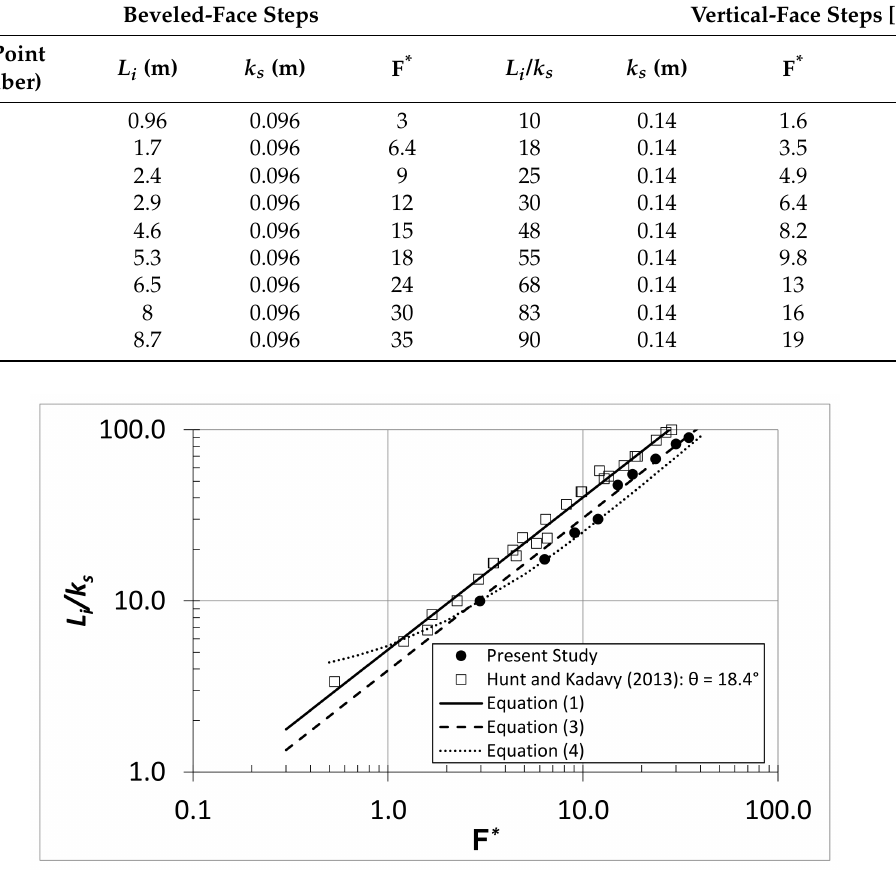
Figure 4. Visually observed free-surface inception point ( L i ) normalized by the step roughness ( k s ) for a vertical face step ( k s = h cos ( θ )) from [6] and beveled face step ( k s = (2/3) h cos ( θ )) as compared to predicted L i /k s using Equations (1), (3) and